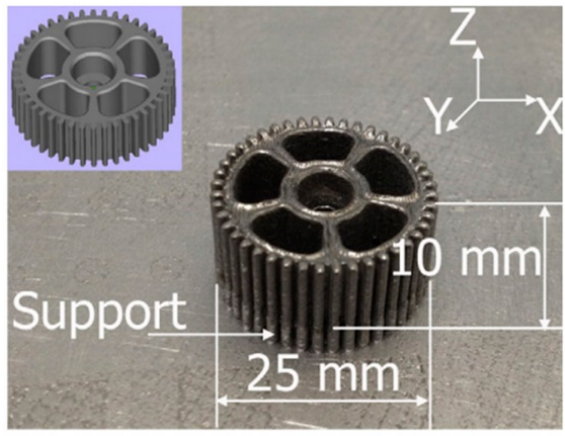
Figure 39. A 3D-printed gear of amorphous metal